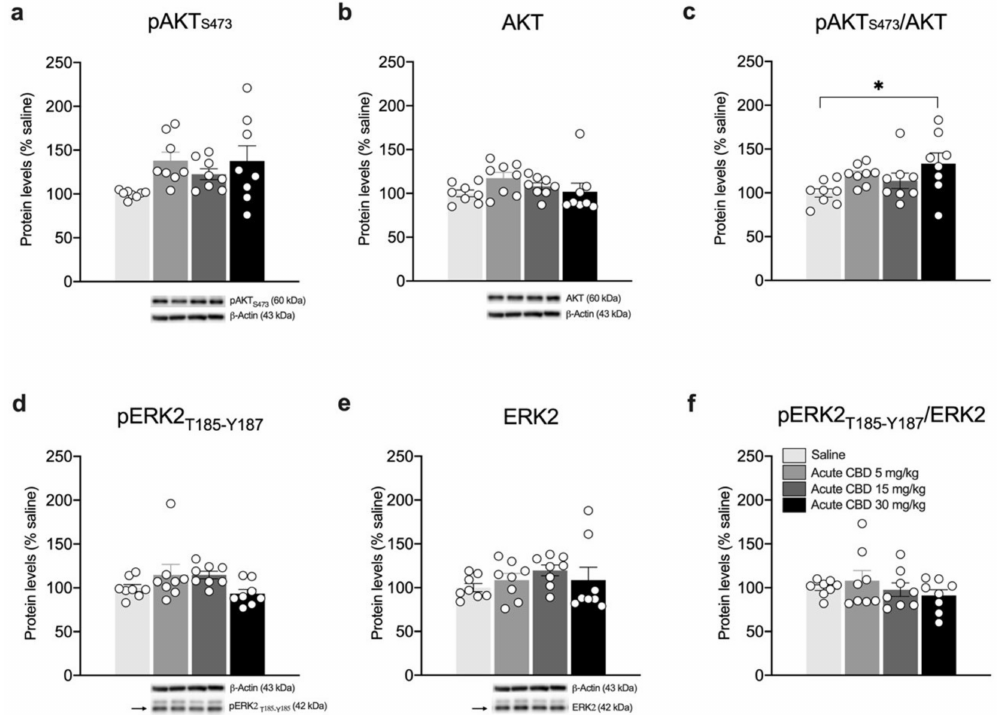
rats. Below the graphs representative immunoblots are shown for mBDNF (14 kDa), pTrkB Y706 (145 kDa), TrkB (145 kDa), and β -Actin (43 kDa) proteins. Bar graphs represent the mean ± SEM from eight independent determinations for each experimental group. Ordinary one-way ANOVA followed by Tukey’s multiple comparisons test, or Kruskal-Wallis one-way ANOVA for ranks followed by Dunn’s multiple comparisons test for non-normally distributed data. * p < 0.05 vs. saline-treated rats. Saline n = 8, CBD 5 mg/kg n = 8 CBD 15 mg/kg n = 8, CBD 30 mg/kg n = 8 (mBDNF n = 7). Then, to investigate whether alterations in the BDNF-TrkB system induced by a single CBD exposure would engage the recruitment of BDNF downstream pathways, we analyzed the expression and phosphorylation of Akt and ERK2 effectors (Figure 5). As shown in Figure 5, while no significant changes are observed either in the phosphorylated (Ser473) (Figure 5a: F(3.28) = 2.907, p = 0.0521) or in the total form of Akt (Figure 5b: KW = 6.804, p = 0.0784), their ratio expressed as pAkt/Akt is significantly increased following the acute CBD treatment at 30 mg/kg (Figure 5c: F(3.28) = 2.959, p = 0.0494, + 33.38% vs. saline p = 0.0328). Conversely, the analysis of ERK2 phosphorylation (Thr185/Tyr187) does not show any relevant changes (Figure 5d: KW= 8.619, p = 0.0348; Figure 5f: KW= 1.054, p = 0.7882), whereas, despite that the ANOVA analysis of ERK2 expression is statistically significant, the multiple comparisons test does not show any relevant change (Figure 5e: KW = 4.662, p = 0.1983).